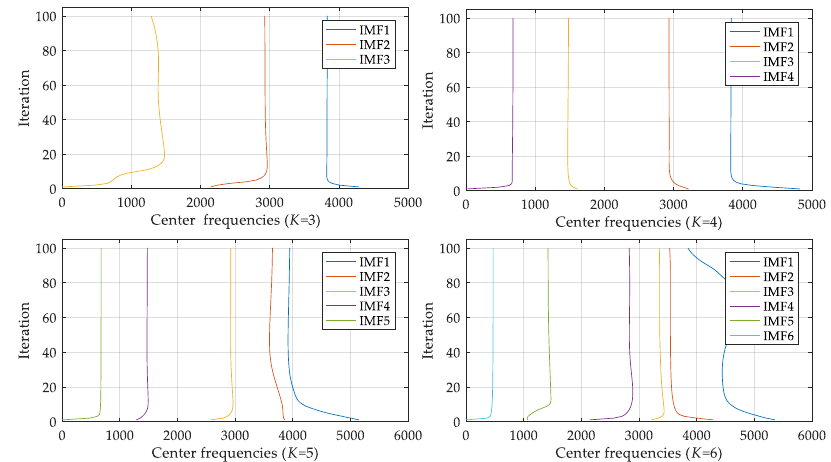
Figure 6. Center frequency distribution with different K values.